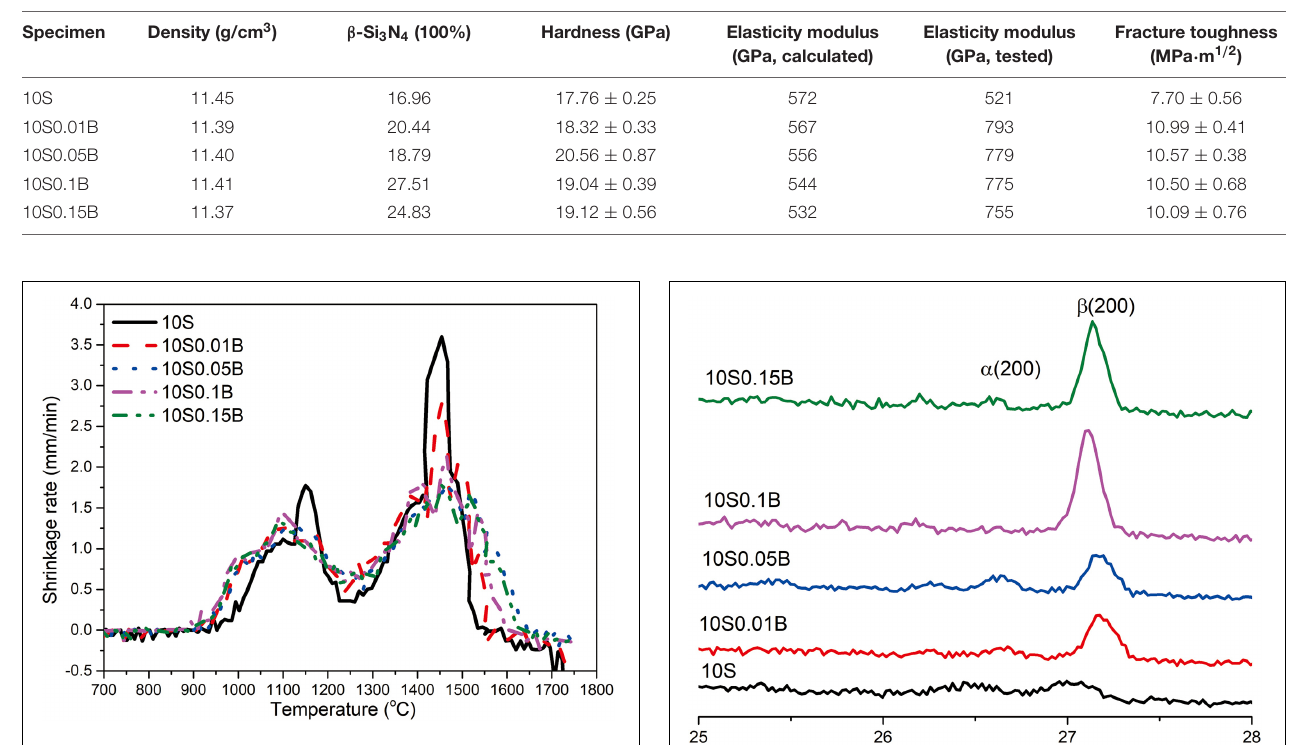
TABLE 1 | Characteristics of WC-Si 3 N 4 -UPBNNF specimens.